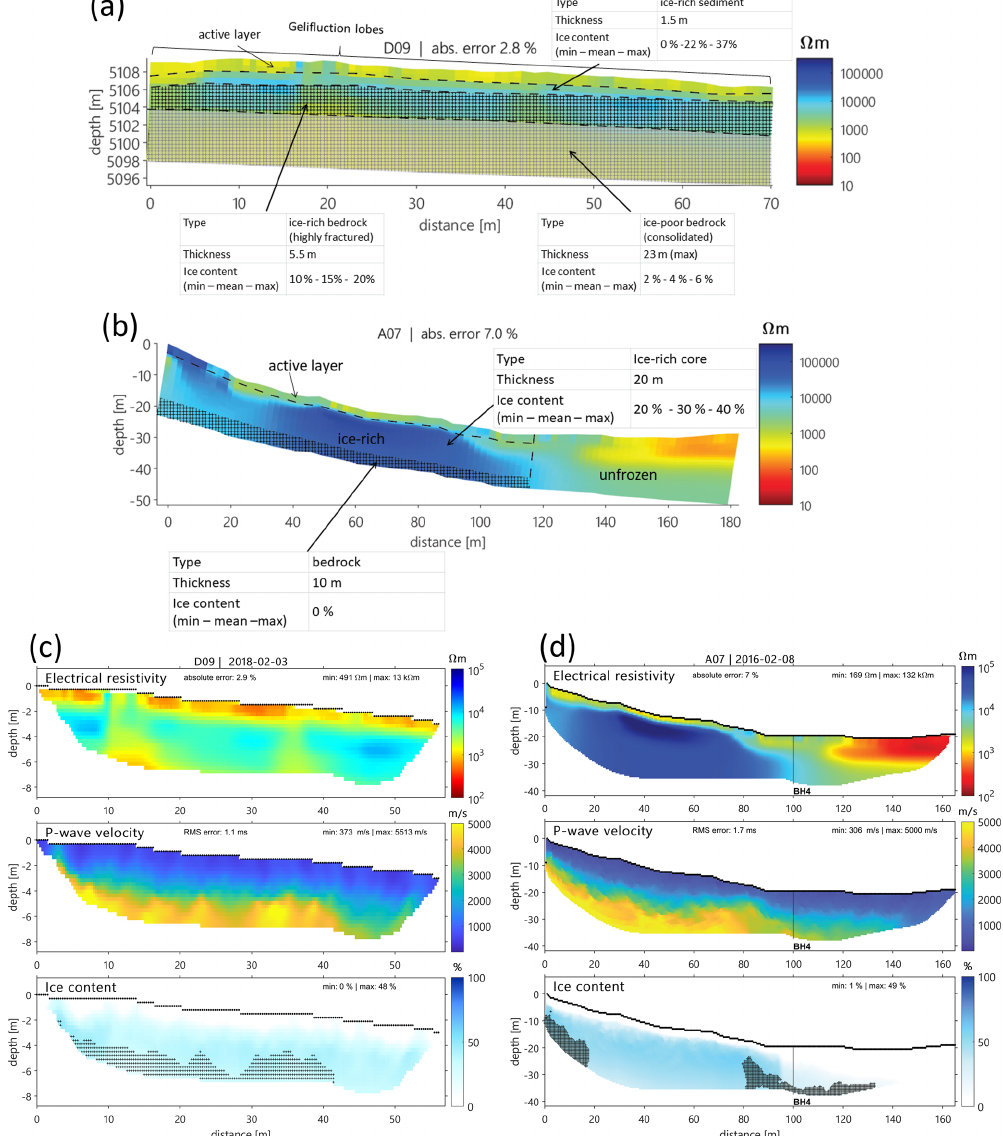
Figure 5. Examples of soil stratigraphy models for both study sites where the 4PM was applied. (a, b) Soil stratigraphy models and (c, d) corresponding 4PM results (ERT, RST, and ice content) (Hilbich et al., 2018). Here, ground ice content estimations stem from the 4PM results: the ice content values for the ice-rich layers correspond to the results from Part 1 of this study (Hilbich et al., 2022a). Ice content estimations for layers that are not considered in detail in Part 1 are mean values from the 4PM results (see Hilbich and Hauck, 2018; Hilbich et al.,